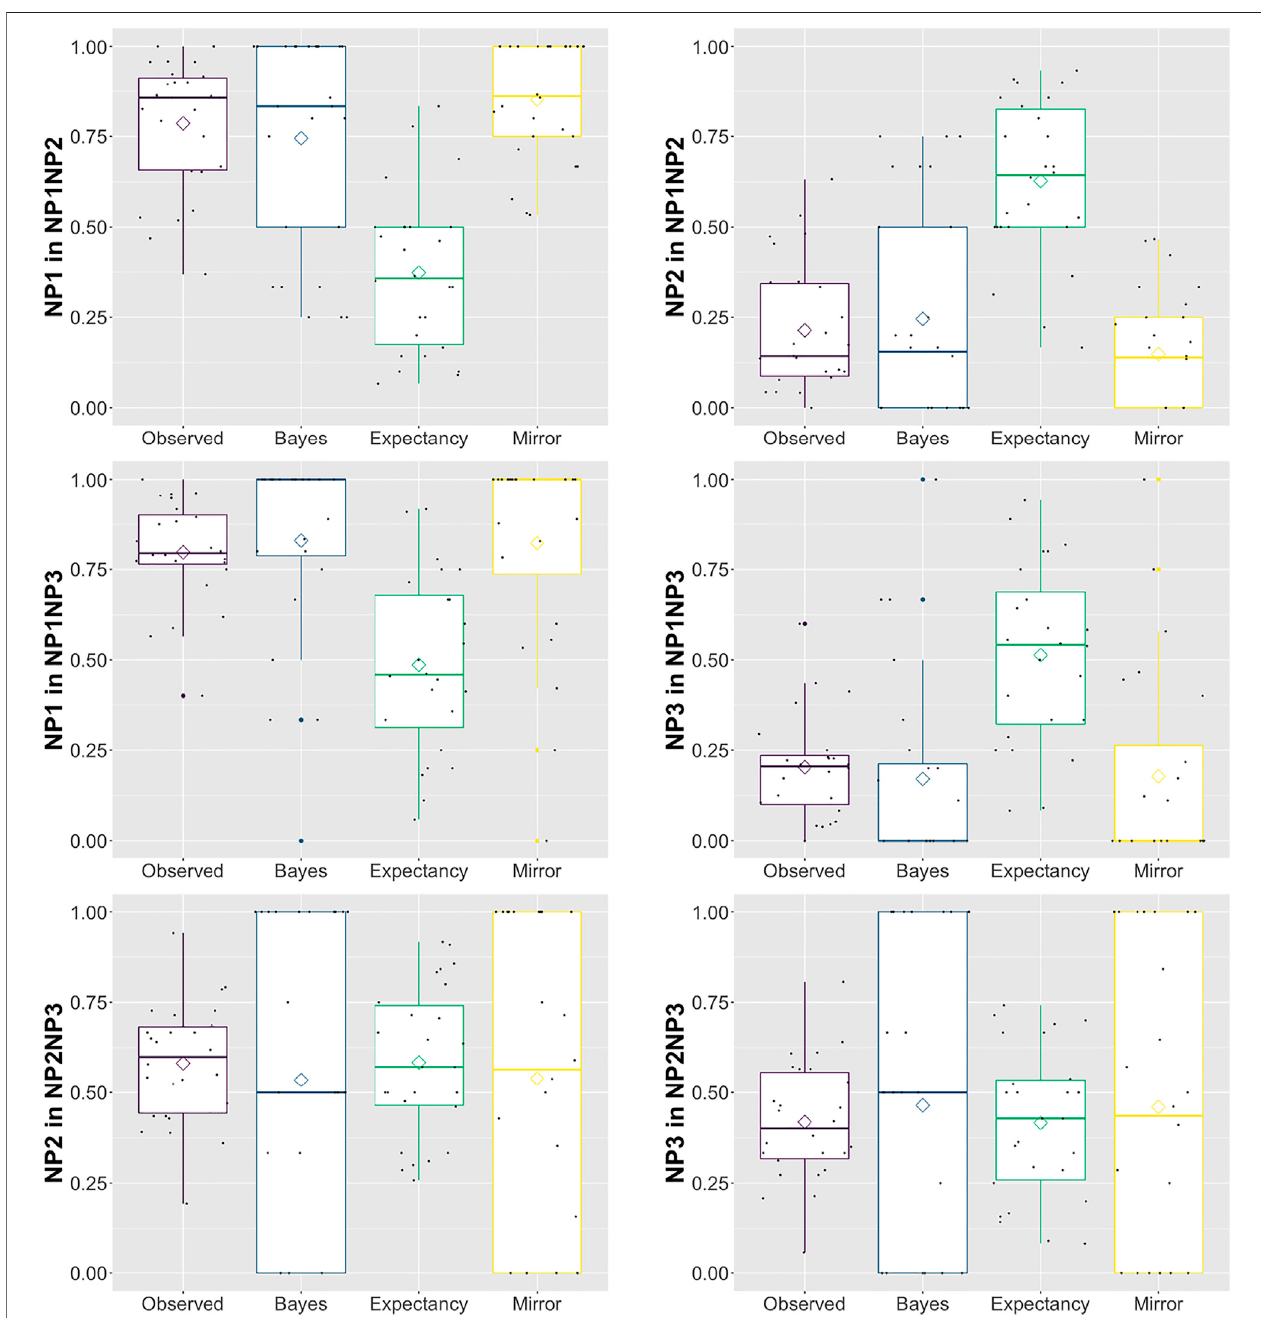
FIGURE 4 | By-item observed values and model estimates for each referent in each ambiguous pair in Experiment 3. Tilted squares indicate the means. Note: the mediansattheextremes(0and1)inthegraphsfortheNP1&NP3ambiguouspairariseinpartduetotherelativelylownumberofobservationsonwhichthemodelestimates arebasedfortheNP1andNP3referents.IntheNP1&NP3condition,themajorityofcontinuationswereabouttheNP2referent,whodoesnot fi gureintothecalculationshere.